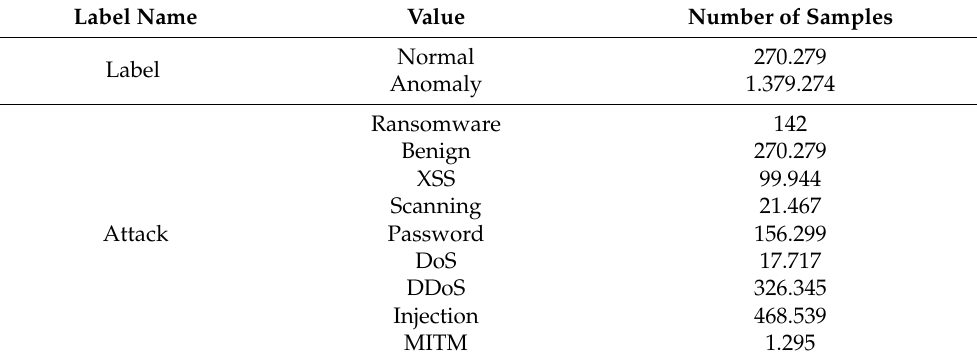
Table 3. NF-ToN-IoT-v2 dataset